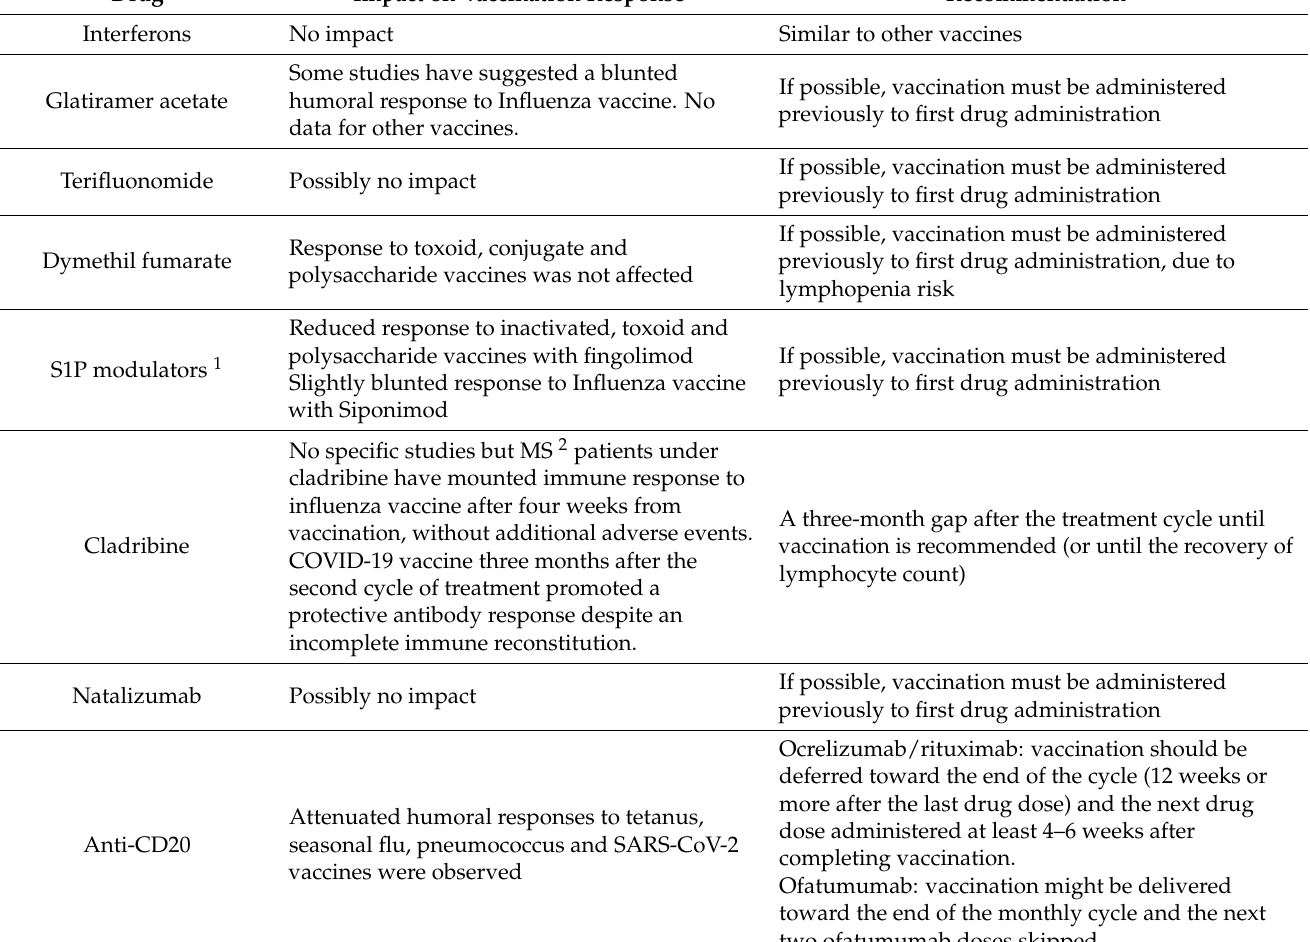
Table 2. Impact of Multiple Sclerosis disease modifying therapies on vaccination and expert recommendations. Drug Impact on Vaccination Response Recommendation Interferons No impact Similar to other vaccines Glatiramer